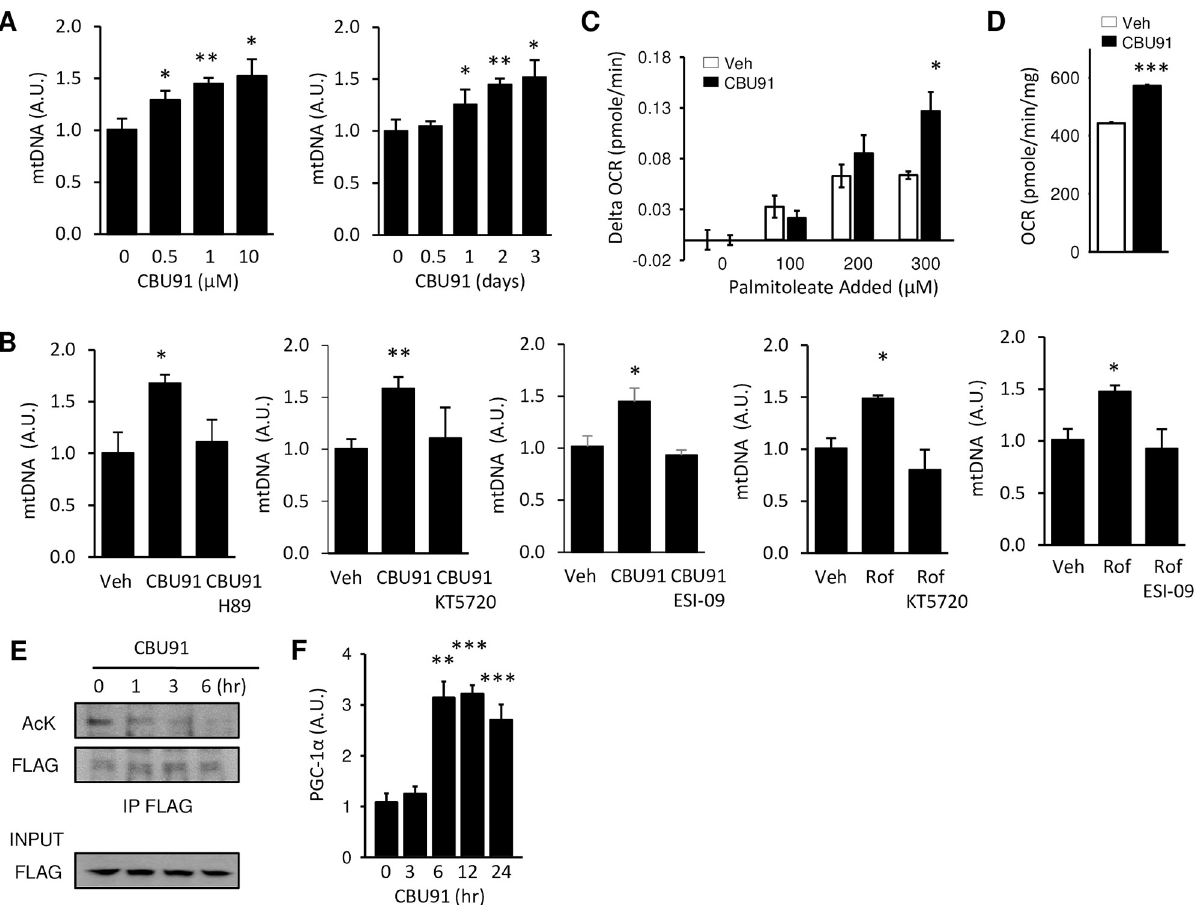
Fig 4. CBU91 increases mitochondrial biogenesis. A, Mitochondrial DNA content analyzed by means of quantitative PCR in C2C12 cells treated with 0–10 μ M CBU91 for 2 days or 10 μ M CBU91 for 0.5–3 days (n = 3). Relative expression values were normalized to untreated cells. B, Mitochondrial DNA content analyzed by means of quantitative PCR in C2C12 cells treated with CBU91 (10 μ M) or roflumilast (10 μ M) in the presence of PKA inhibitors (H89, KT5720) or EPAC inhibitor (ESI-09) for 2 days (n = 5). C, Change in oxygen consumption rate (Delta OCR) in C2C12 with palmitoleate injection (100–300 μ M) after 6 hr treatment with CBU91. D, Oxygen consumption rate (OCR) in C2C12 myotubes 6 hr after treatment with CBU91. CBU91 pretreatment increases basal oxygen consumption rate (OCR) compared with control. E, To determine PGC-1 α acetylation, we immunoprecipitated with an Flag antibody and immunoblotted for acetylated lysine (AcK) antibody in C2C12 myotubes treated with 10 μ M CBU91 for 1–6 hr. F, The mRNA levels (arbitrary units) of PGC-1 α in C2C12 myotubes after 5 μ M CBU91 treatment for 3–24 hrs were measured by real-time PCR (n =